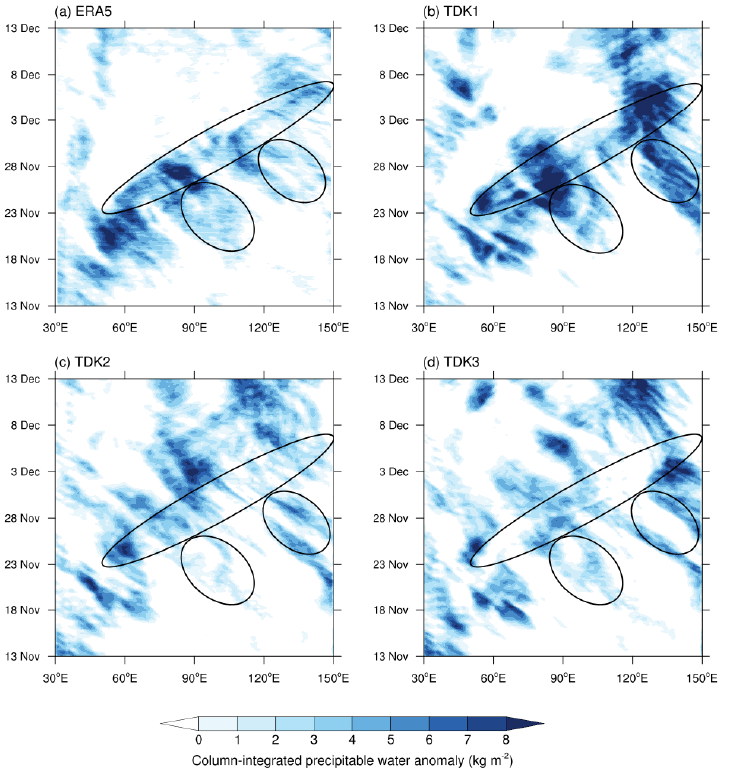
Figure 5. Longitude-time sections of 3-hourly column-integrated precipitable water anomaly (kg m −2 ) from ( a ) ERA5, ( b ) TDK1, ( c ) TDK2, and ( d ) TDK3 experiment from 13 November to 12 December 2011. Data are averaged between 10° N and 10° S with the time average removed. Black circles in ( a ) represent the propagations of column-integrated precipitable water anomaly from the ERA5. For the TDK2 and TDK3 experiments, the atmosphere in the MC region around 120° E is always dry before 3 November (Figure 5c,d). In the TDK2 experiment, the water vapor is hard to collect in the MJO envelope (see the big circle of Figure 5c,d). An apparent jump of a positive precipitable water anomaly appears in this region as the MJO precipitation moves from the eastern Indian Ocean to the western Pacific across the MC in the TDK3 experiment. Such jumpy behavior over the MC demonstrates the sensitivity of the simu- lated water cycle to the PBL parameterization schemes. Ulate et al. [62] found similar re- sults in this region. When the YSU and MYJ PBL schemes are used, dry biases produced by the PBL scheme can penetrate the middle troposphere but disappear when the UW scheme is used. 3.3. MSE Budget It is noted that the positive MSE tendency ahead of the MJO convective center is cru- cial for the eastward propagation of the MJO [27]. The MSE is a thermodynamic variable that describes the state of an air parcel. It is similar to the equivalent potential temperature. As mentioned in Yano and Ambaum [64], MSE is a useful quantity in understanding moist convection, and it is conserved under moist adiabatic processes and hydrostatic balance. The MSE is regarded as the sum of dry static energy (DSE) and Latent Static Energy (LSE). Following Yano and Ambaum [64], the DSE and LSE are defined as 𝐷𝑆𝐸 = 𝐶 𝑝 ∗ 𝑡 + 𝑔 ∗ 𝑧 ,